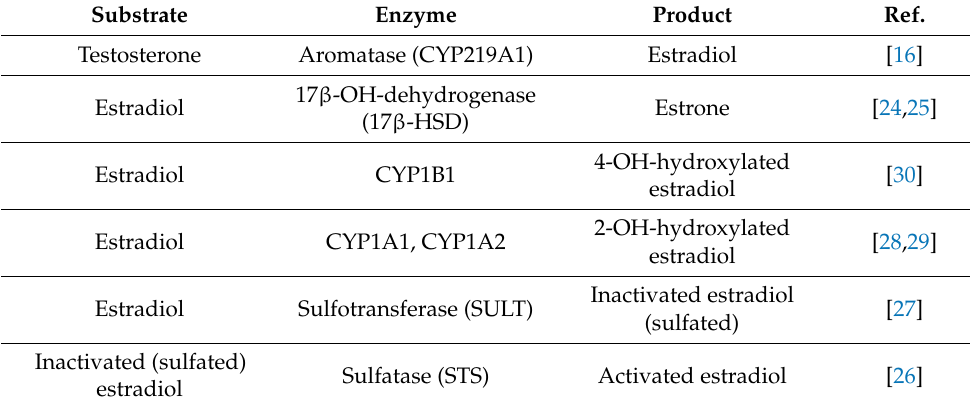
Table 1. Reagents of the main metabolic processes regarding estradiol that have been investigated with in silico